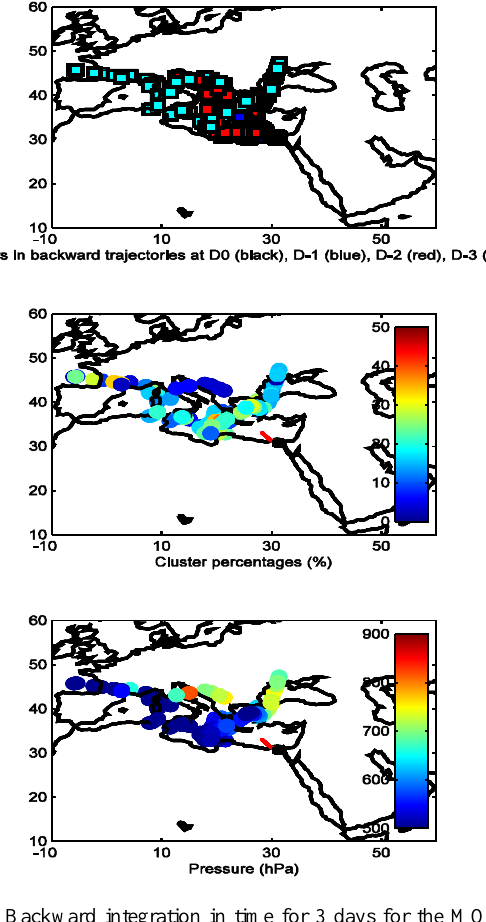
Fig. 3. Backward integration in time for 3 days for the MOZAIC vertical profile measurements and for air masses arriving at 1500– 5000m over Cairo during a period with high ozone levels in the lower troposphere (30 July 2003, Flight: MA20030730103). The results are summarized on centroids of 5 clusters, and include every 12h latitude, longitude, pressure and percentage of representation. The results shown above are for the 1.5–5km layer. Top plot shows the clusters positions at day 0 (black), day-1 (blue), day-2 (red), and day-3 (cyan). Middle plot shows the percentages of clusters at day- 3. Finally, bottom plot shows the pressure of the clusters at day-3. The red line is the aircraft trajectory during ascent/descent.